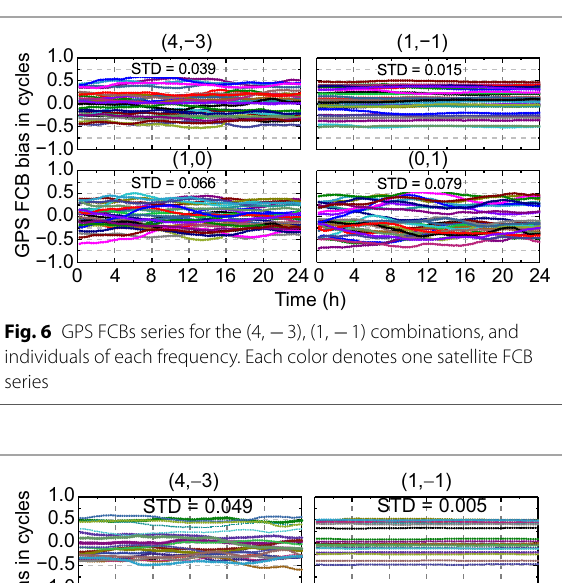
3), (1, 1) combinations, and − −